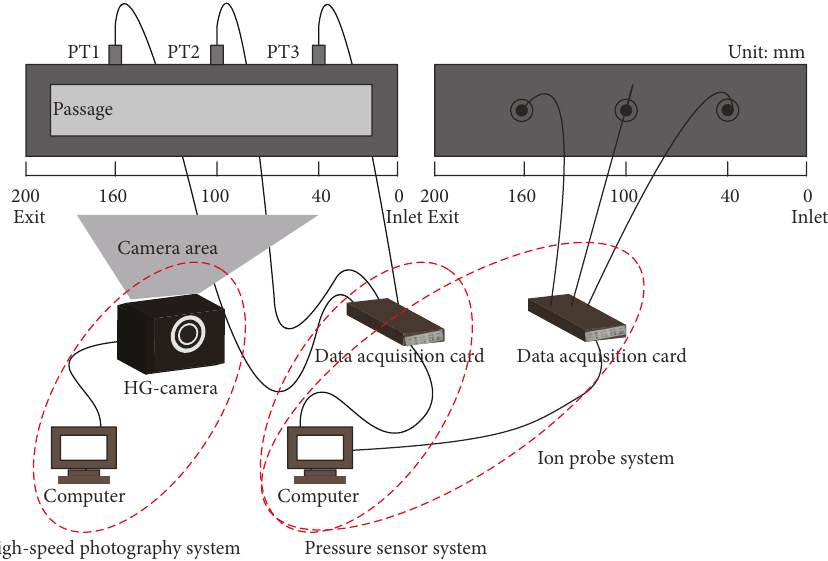
Figure 6: Schematic illustration of the data acquisition system.